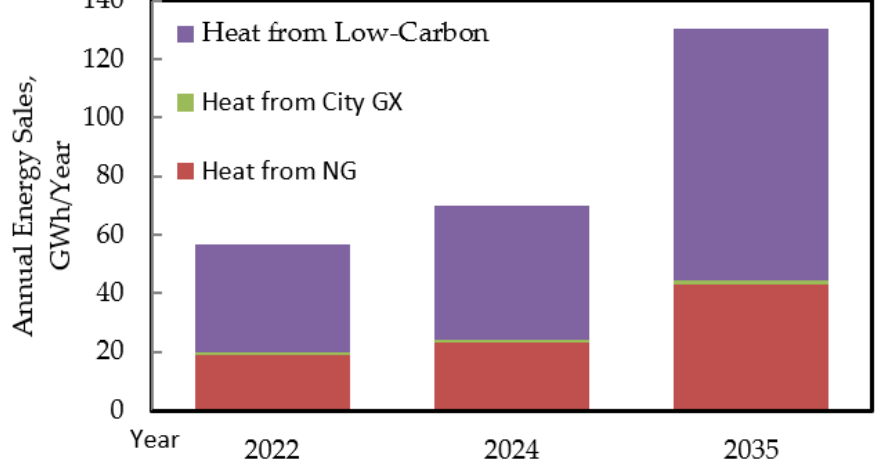
Figure 2. Surrey City Energy’s projected annual demand and target energy sources.